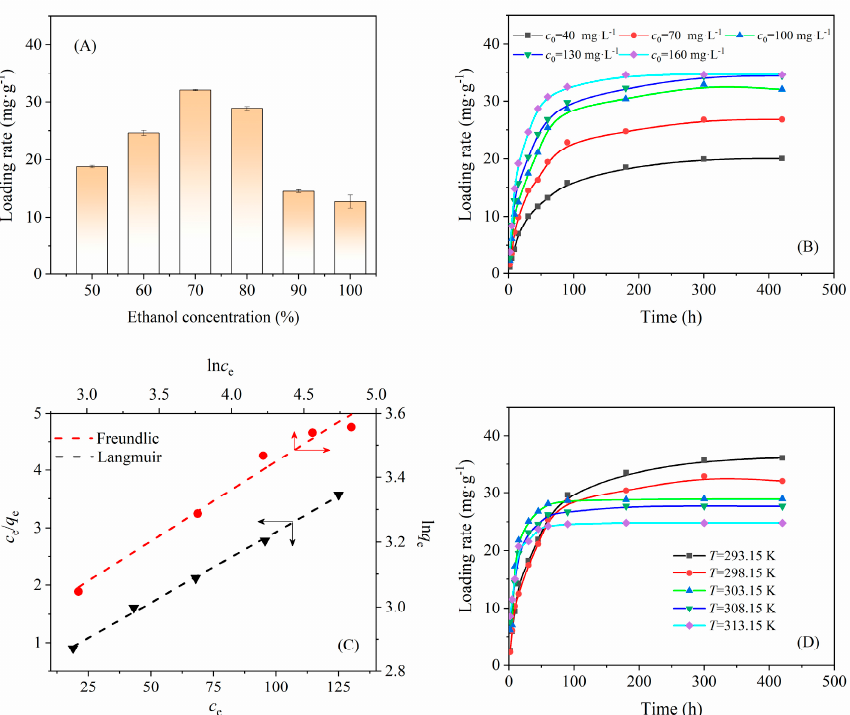
Figure 6. ( A ) Effects of ethanol concentration on the loading rate of CA-CSNPs ( c 0 = 100 mg · L − 1 , T = 298.15 K); ( B ) effects of the initial concentration of PTX ( c 0 ) on the loading rate ( T = 298.15 K, concen- tration of ethanol = 70 wt %); ( C ) fitting curves of Langmuir and Freundlich isotherm adsorption equation; ( D ) effects of temperature ( T ) on loading rate( c 0 = 100 mg ∙ L − 1 , ethanol concentration = 70 wt %).The CA ‐ CSNPS sample was prepared with a crosslinking agent amount of 15 wt %, an aqueous starch concentration of 6.0 wt %, an oil–water ratio of 10:1, a total surfactant amount of 0.20 g ∙ mL − 1 , and a CHPTAC amount of 4.05 wt %. The obtained CA ‐ CSNPs showed a diameter of 252 nm and an